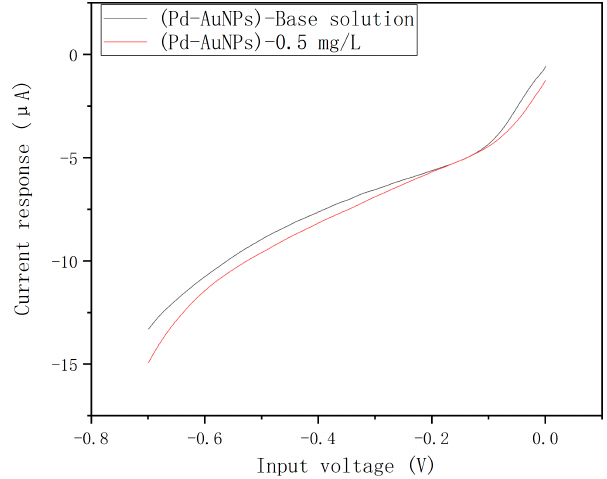
Figure 5. The linear scanning curves of the Pd-AuNPs composite sensing film modified chip in the base solution and the nitrate solution with a concentration of 0.5 mg · L − 1 . Table 1. The responses to nitrate of the chips modified with different sensing film.